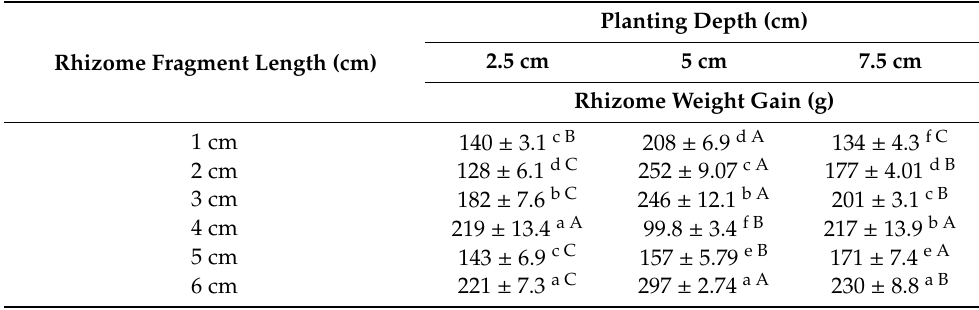
Table 3. E ff ects of planting depth and fragment length on the rhizome weight gain. Planting Depth (cm) 2.5 cm 5 cm 7.5 Rhizome Fragment Length (cm)